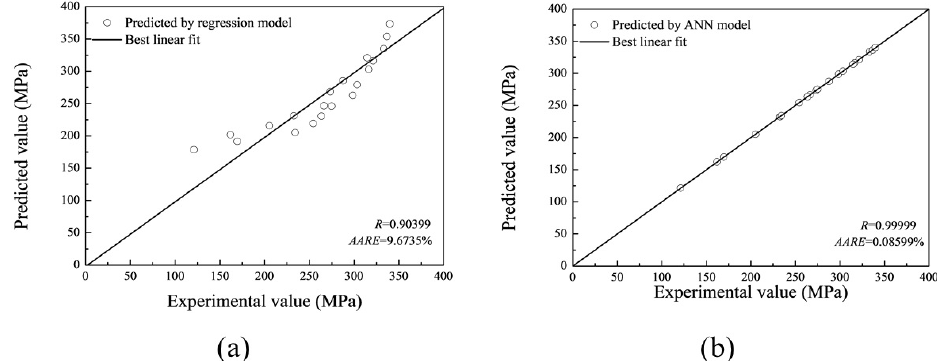
Figure 10. Correlation between experimental and predicted flow stresses at strain of 0.5 by (a) regression model and (b) ANN model.